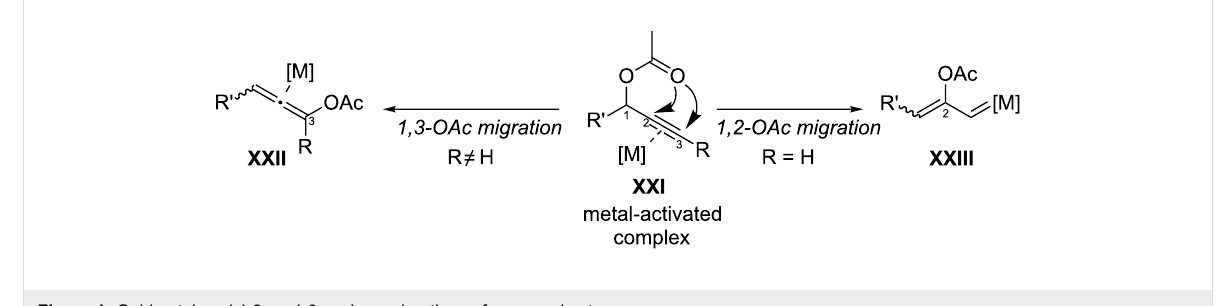
Figure 1: Gold-catalyzed 1,2- or 1,3-acyloxy migrations of propargyl esters.